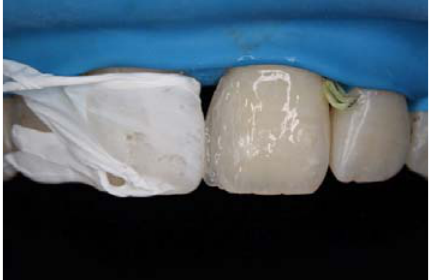
Figure 5: A thin layer of BW shade opaque composite resin was placed roughly as the second layer.